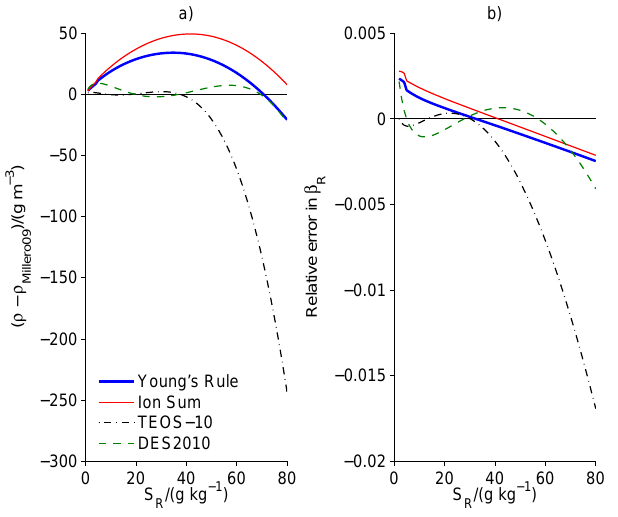
Fig. 3. Comparison between (a) model densities and (b) haline contraction coefficient β R determined from the model, and those obtained by direct measurements (Millero and Huang, 2009), for salinities up to 80 g kg − 1 at t = 25 ◦ C.